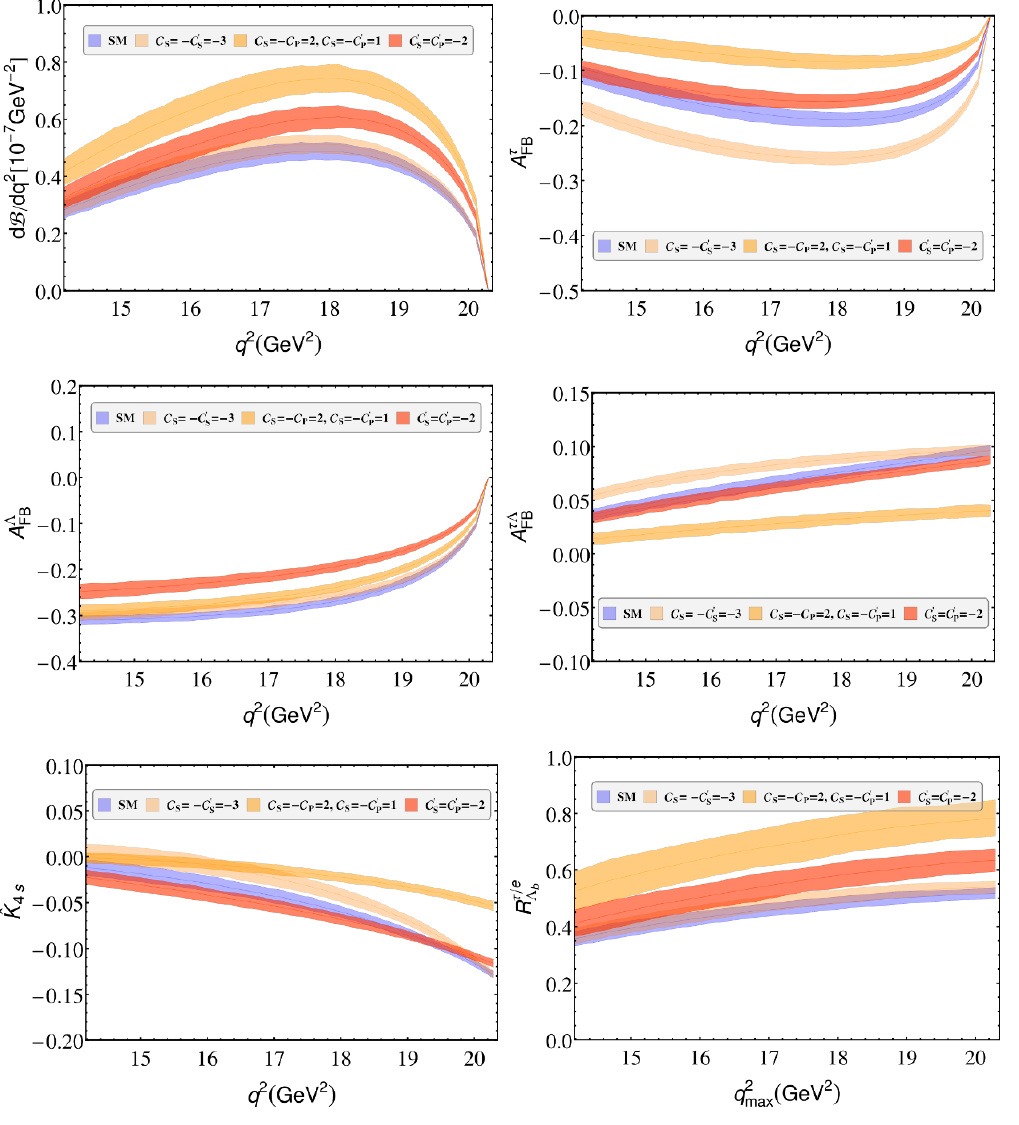
Figure 4 . The (cid:3) b ! (cid:3)( ! p(cid:25) ) (cid:28) + (cid:28) (cid:0) observables in the presence of SP couplings. The bands correspond to the uncertainties discussed in text. Since the OPE at large q 2 does not capture local resonance structures, the distributions can be locally o(cid:11) from the OPE